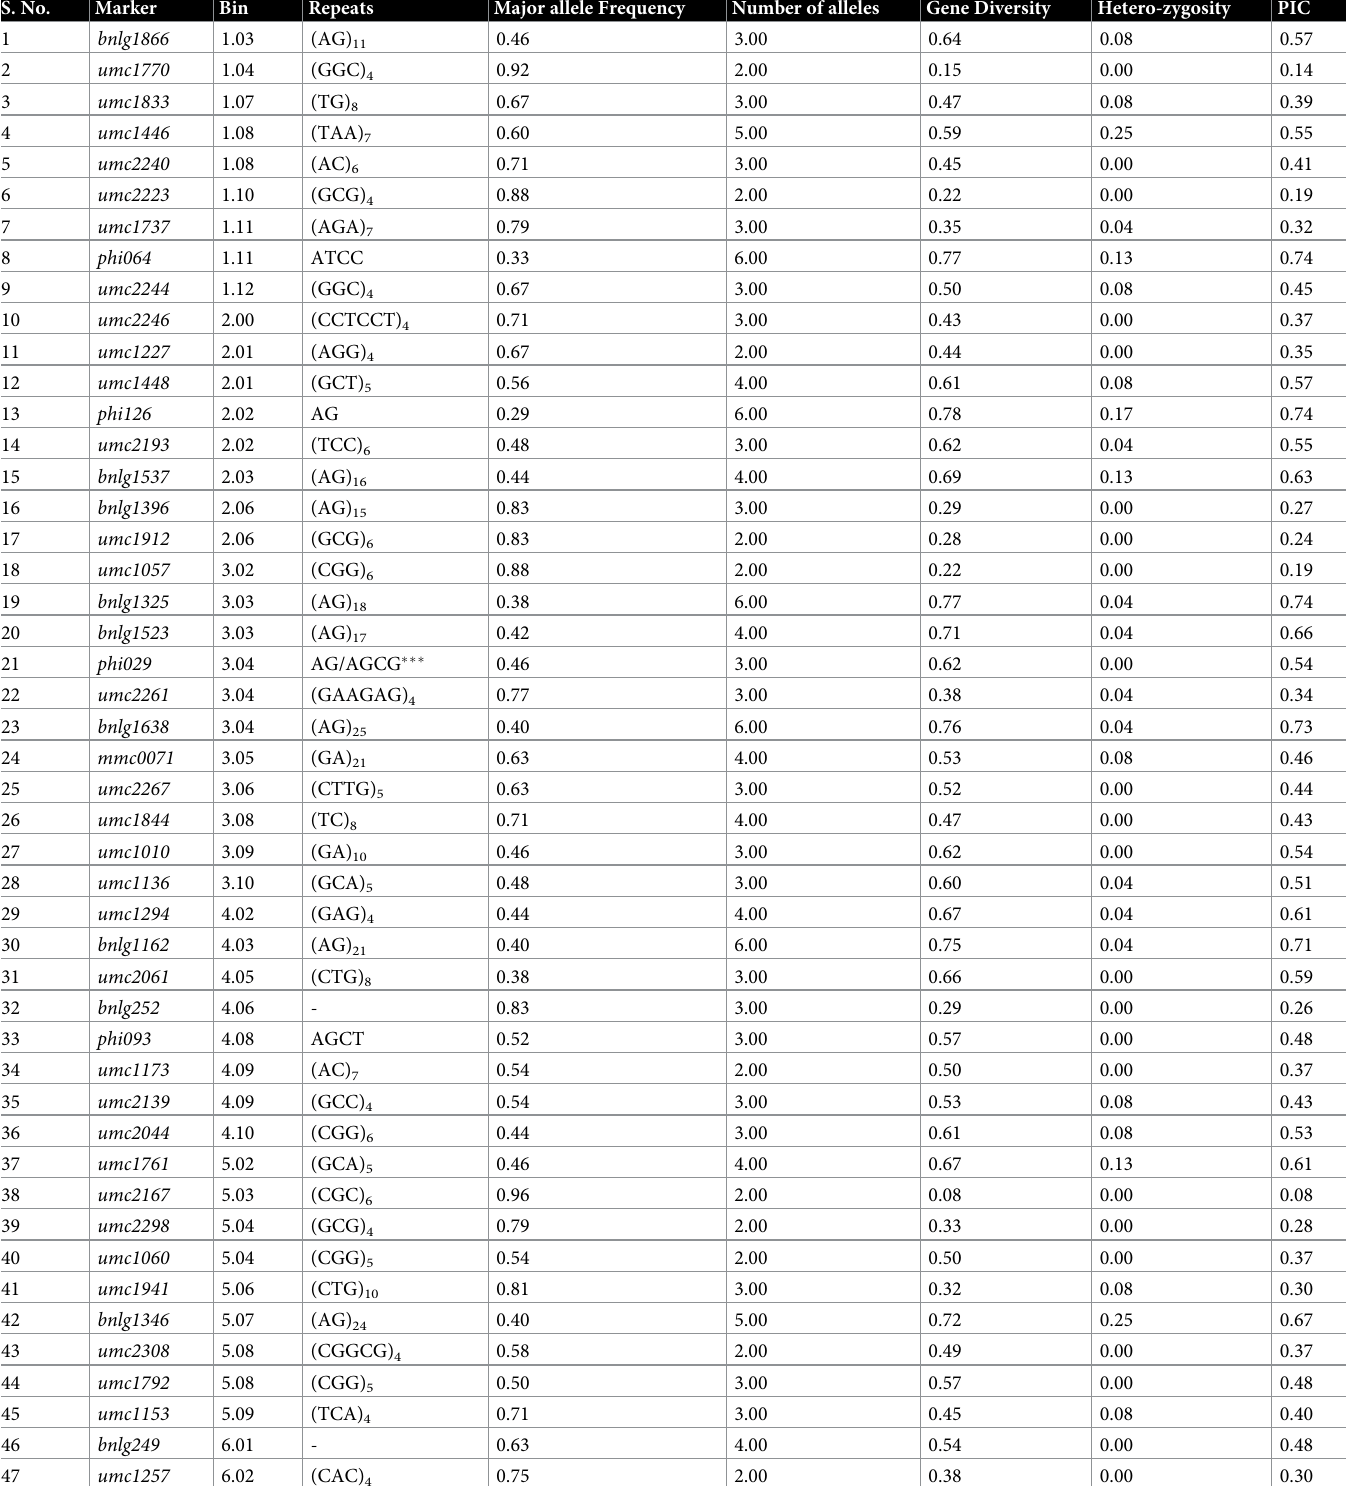
Table 2. Primer details and summary statistics of genotyping assay in 24 inbreds. S.